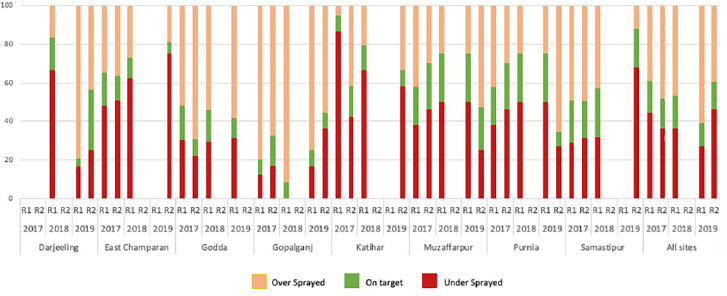
Fig 3. Percentage of household structures that received the correct dose, overdose and under dose of alpha- cypermethrin. R1-Round 1; R2-Round 2; % over sprayed- > 30 mg/m 2 ; % on target-20-30mg/m 2 ; % under sprayed — < 20 mg/m 2